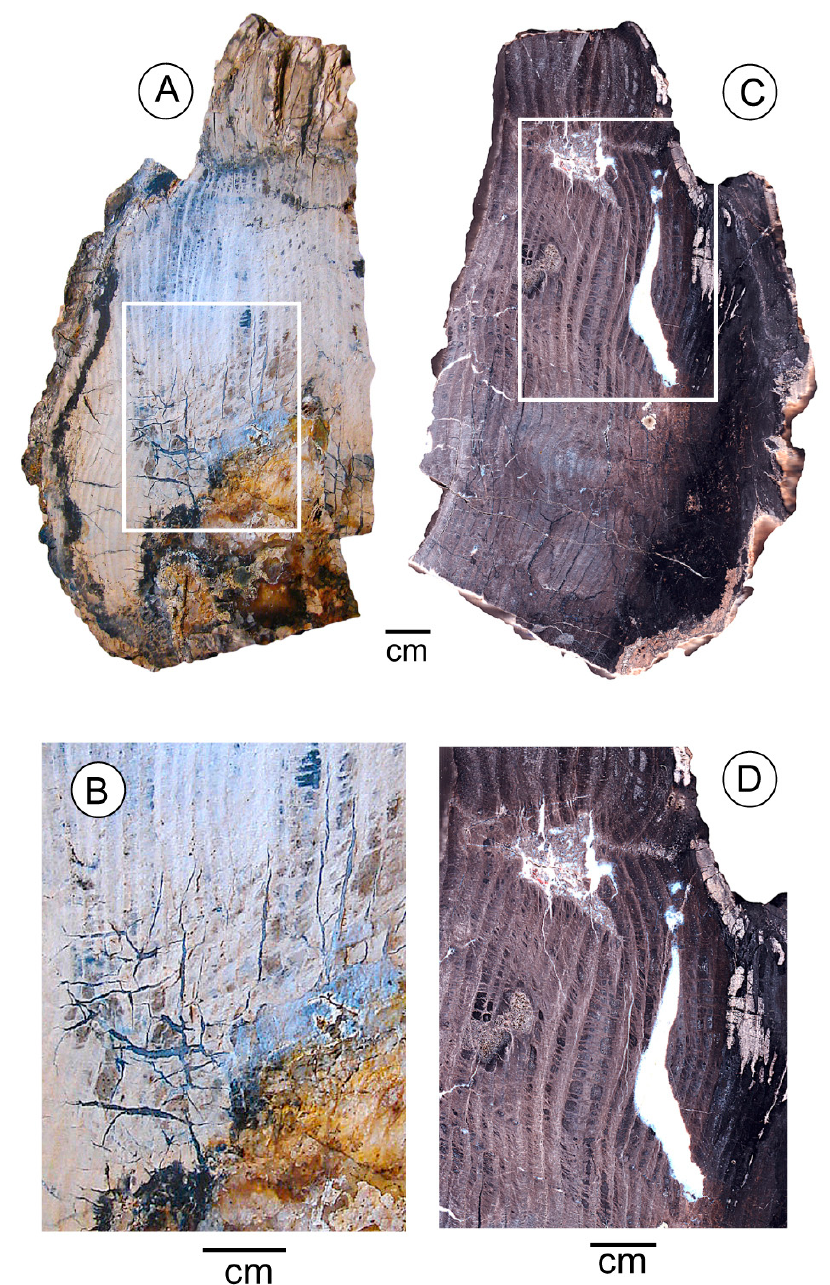
Figure 14. Specimen 25 (log 12). Density of 1.99 g/cm 3 indicates opal composition. ( A,B ):